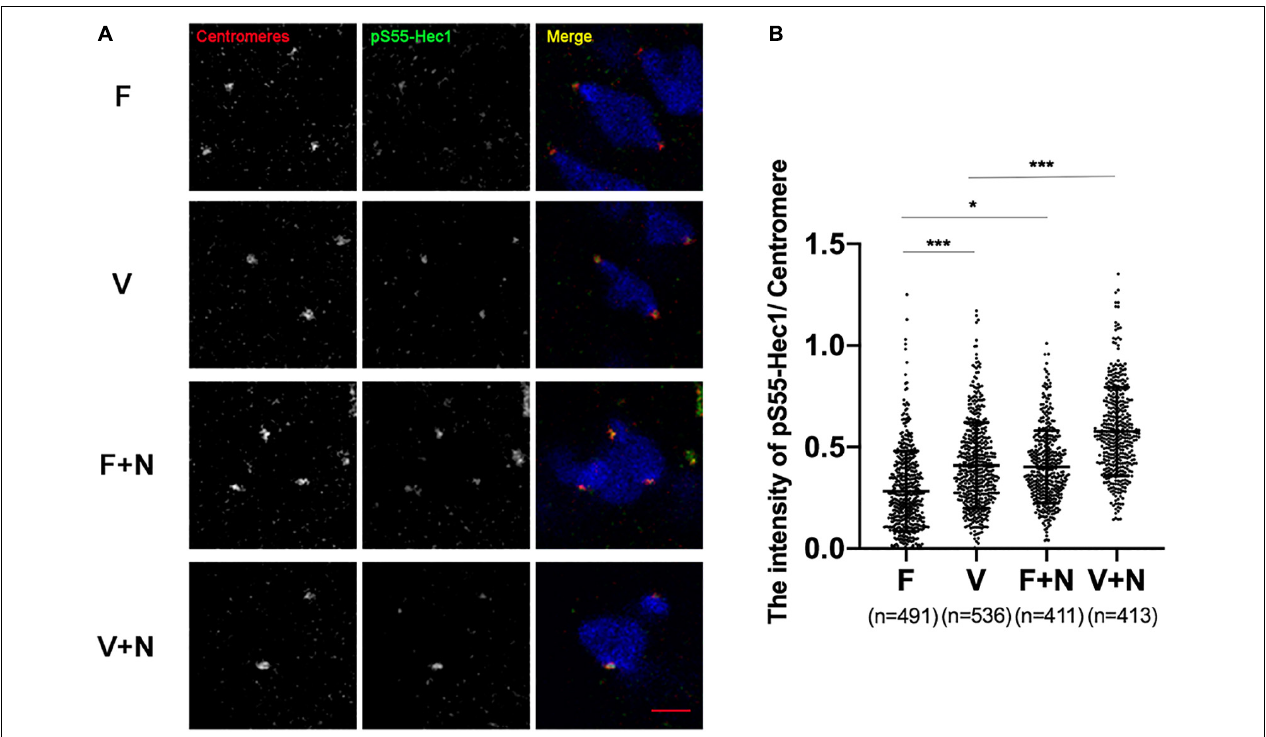
FIGURE 5 | The activity of Aurora B/C in vitrified oocytes did not reach the threshold of recruiting SAC. (A) We treated oocytes with 400 nM nocodazole at 5 h after GVBD and fixed oocytes at 6 h after GVBD to detect chromosomes (Blue), centromeres (Red), and pS55-Hec1 (Green). 22 oocytes in F group, 19 oocytes in V group, 19 oocytes in F+N group and 18 oocytes in V+N group were detected. Scale bar represents 2 µ m. (B) The intensity of pS55-Hec1/ centromere was quantified in F, V, F+N, and V+N group, respectively. F: n = 491; V: n = 536; F+N: n = 411; V+N: n = 413, n : the number of the Centromere. The experiments were replicated three times.